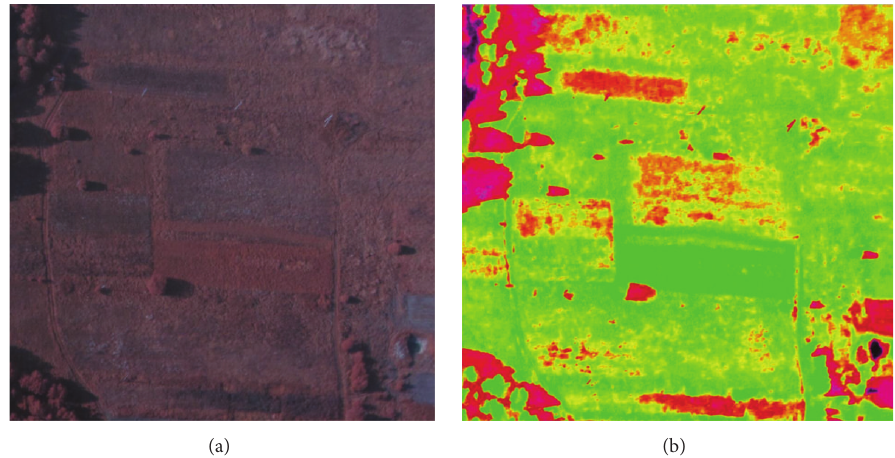
Figure 13: Images for plants observation: (a) a spectral image; (b) the compiled colour images for vegetation state